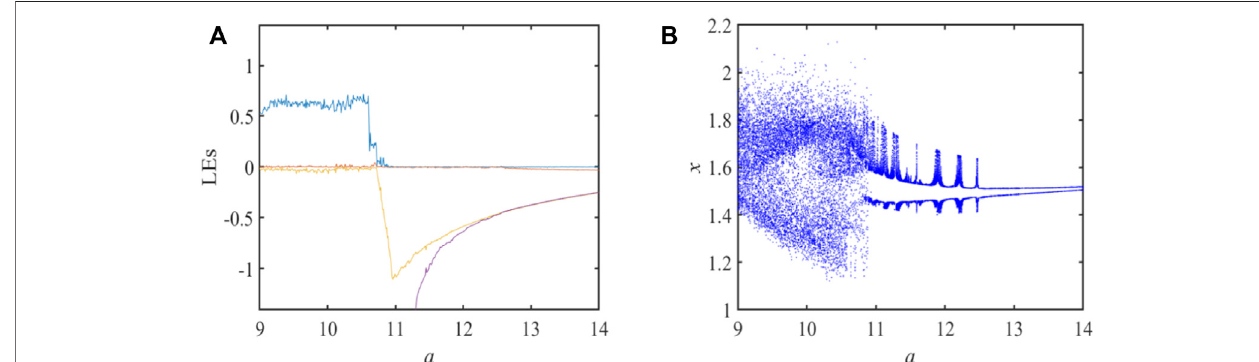
FIGURE 3 | (A) LEs, (B) bifurcation diagram.